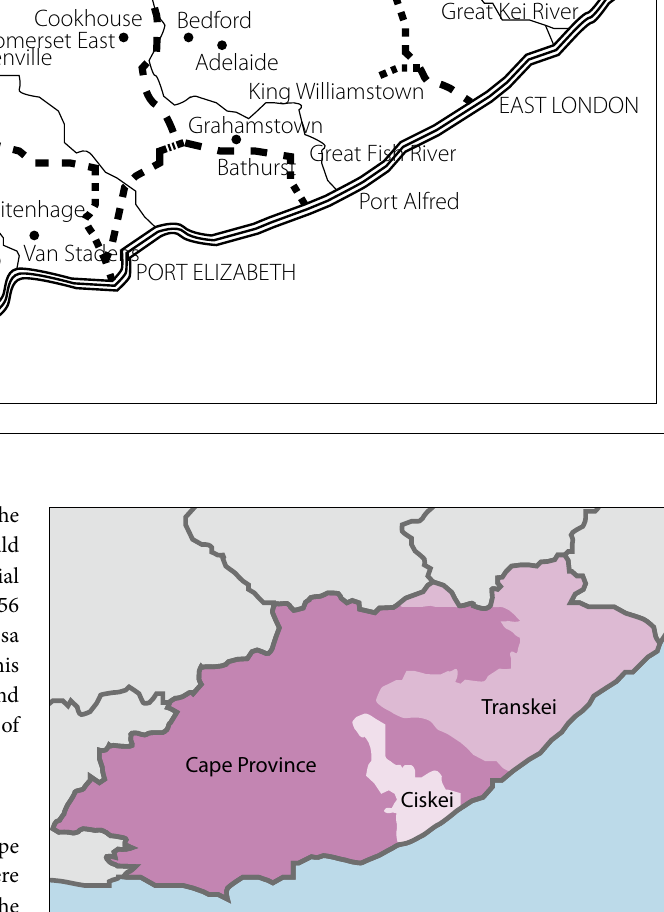
Fig. 2. The Bantustans of the Ciskei and